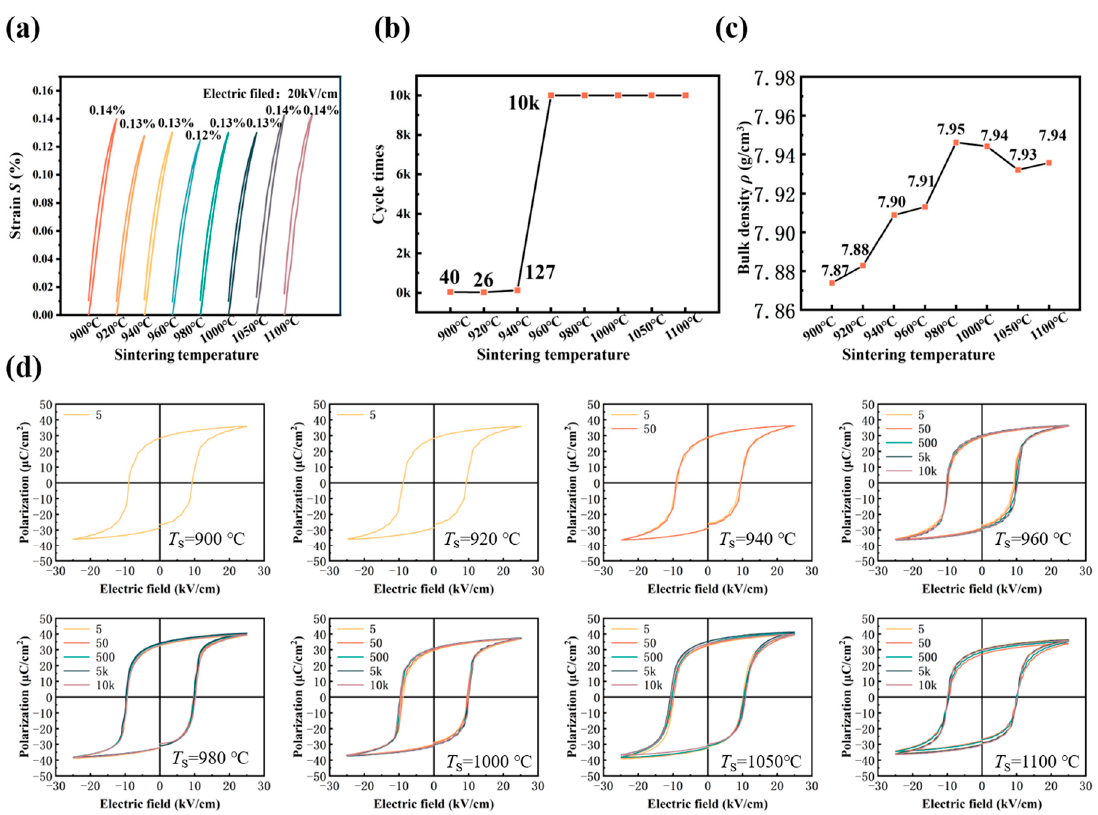
Figure 6. ( a ) Unipolar strain ( S-E ) curves of the 0.2 wt% Li 2 CO 3 -modified ceramics under 20 kV/cm; ( b ) The maximum cycle times; ( c ) Density of the 0.2wt% Li 2 CO 3 -modified ceramics; ( d ) Cyclically P-E curve of piezoelectric ceramics under 25 kV/cm.